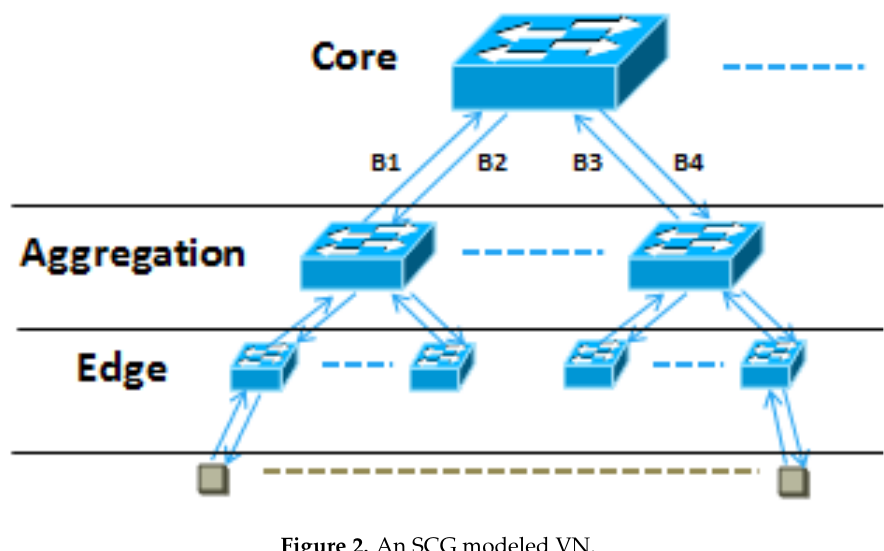
Figure 2. An SCG modeled